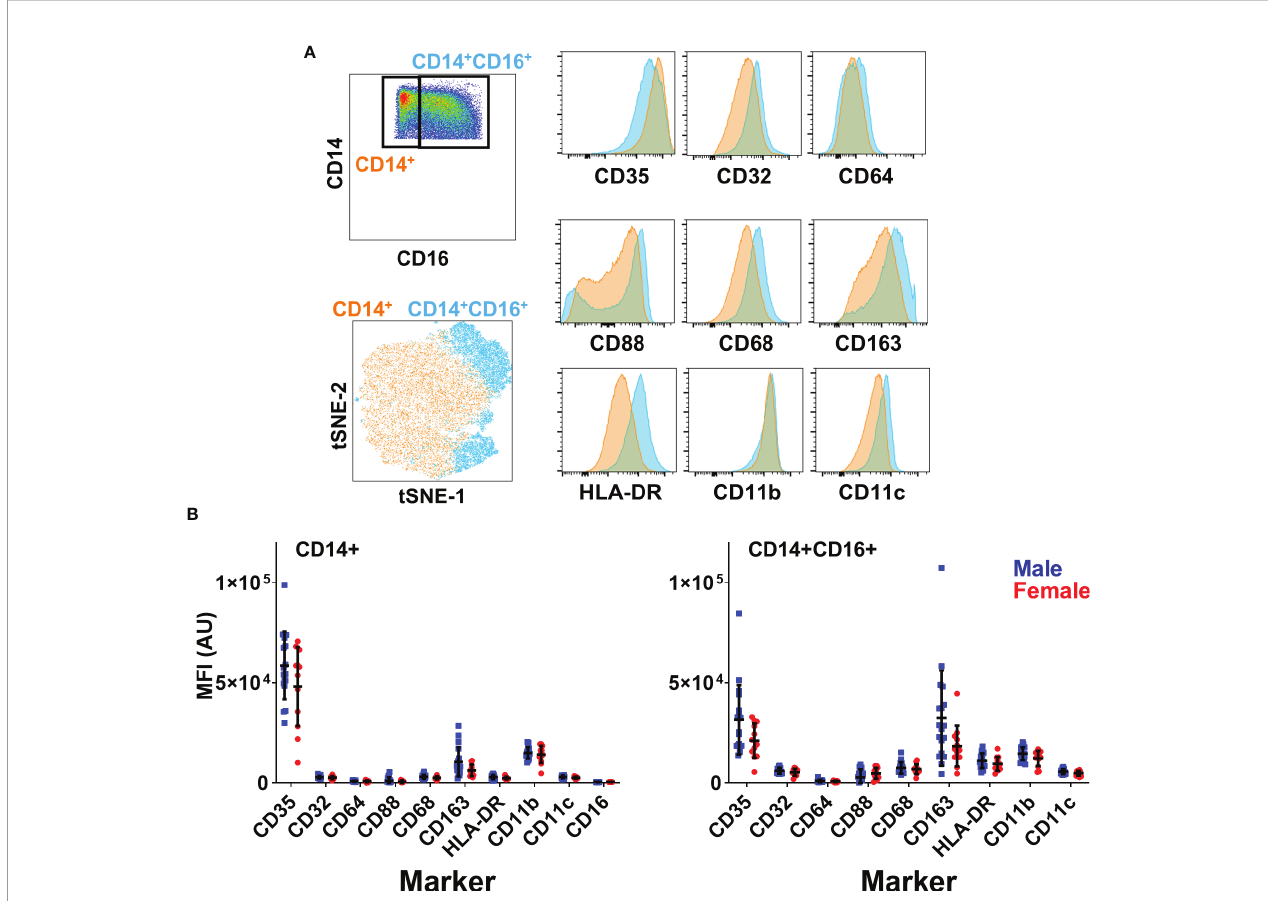
FIGURE 4 | No differences in monocyte phenotype based on sex. (A) Surface phenotype of liver CD14+ and CD14+CD16+ monocytes. T-SNE dimensionality reduction was performed on monocytes concatenated from all liver samples (5000 cells per sample). (B) Expression of surface markers in monocyte subsets by sex n=18 males, 12 females. Figures depict mean +/-